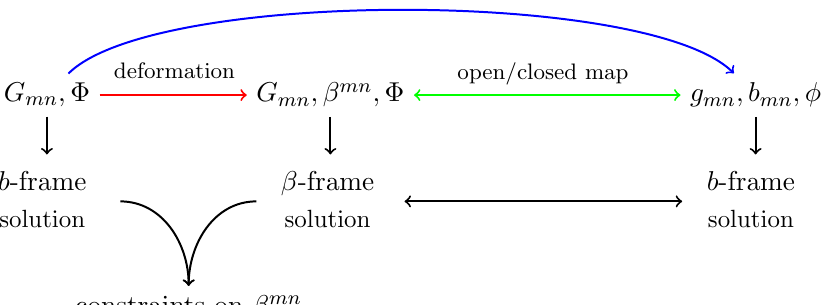
Figure 1 . Relationships between the relevant theories and their solutions. b -frame refers to the standard supergravity (possibly generalised), while β -frame is the theory of [28]. Yang-Baxter deformation acts within usual supergravity, but we interpret it as a composition of the open/closed string map with a deformation by β mn . This leads to the constraints for β mn (essentially the CYBE) arising from supergravity field